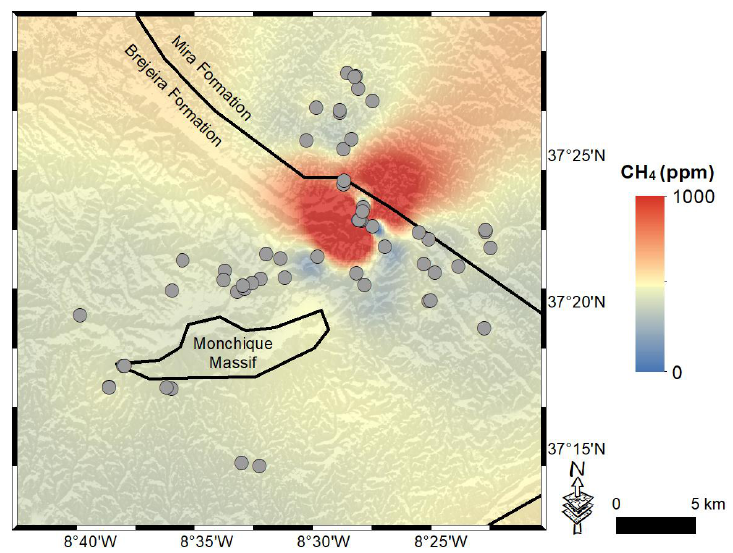
Figure 9. Map showing the location of sampling points (grey circles) and the anomalies of hydro- carbons (red zone), represented by the most abundant one (methane); adapted from Barberes et al.